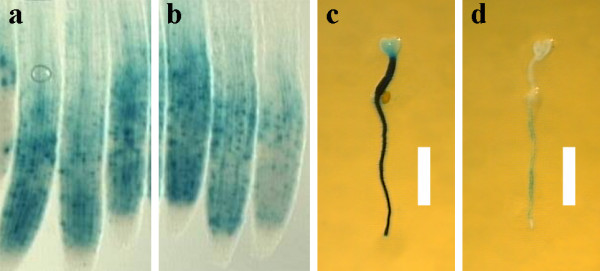
Control of AXR3 expression by PAX1. HS::axr3-1NT-GUS expression in (a) wild type and (b) pax1-1, 2 h following heat induction. AXR3::GUS expression in (c) wild type and (d) pax1-1 seedlings stained for GUS activity 2 dag. Bar = 2 mm.